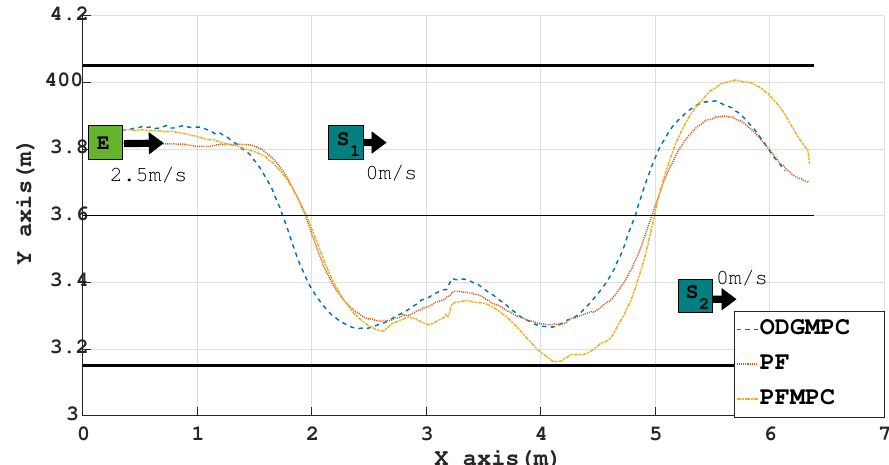
Figure 25. Results of the path from Scenario 3 for two static obstacles.